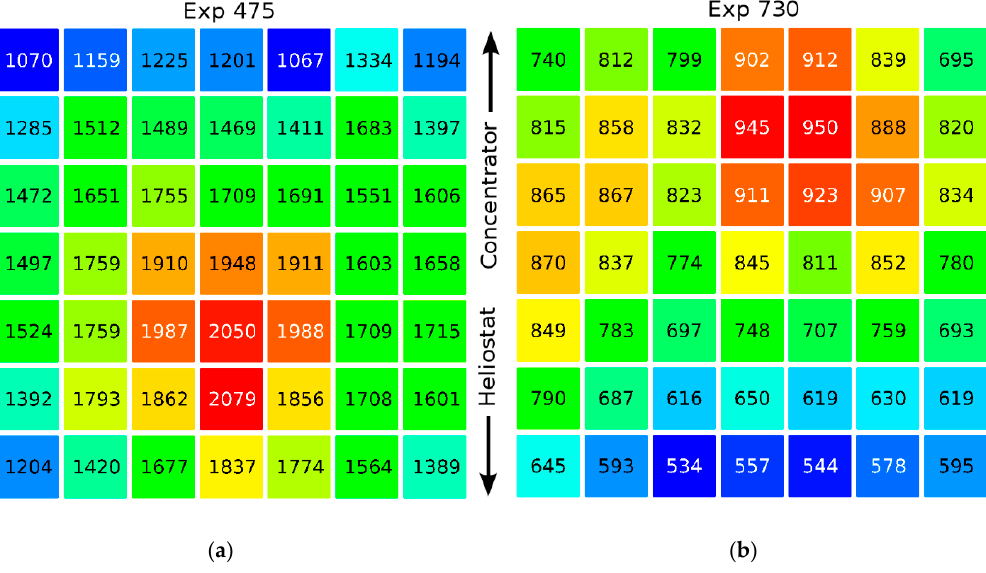
Figure 5. Energy flux (in kW / m 2 ) measured at z = 475 mm ( a ) and z = 730 mm ( b ) below the concentrator axis, using a relative colour scale, from blue (cold) to red (hot). The x axis is horizontal. The vertical y direction is aligned with the paraboloid axis, pointing above ( + y) to the paraboloid concentrator, and below ( − y) to the